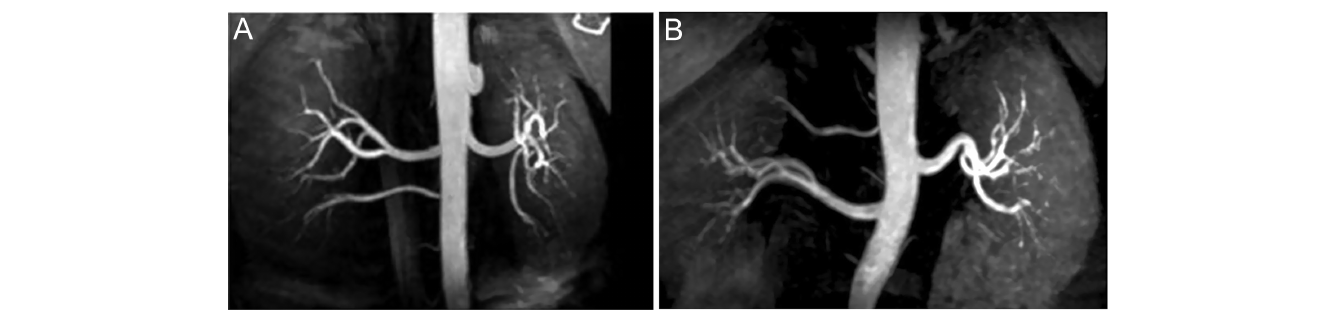
Figure 4. Coronal reformatted MIP images of Inhance sequence for (A) a 39-year-old female patient, right aberrant renal artery (supplying the inferior pole) variation. (B) a 46-year-old female patient, right aberrant renal artery (supplying the superior pole)